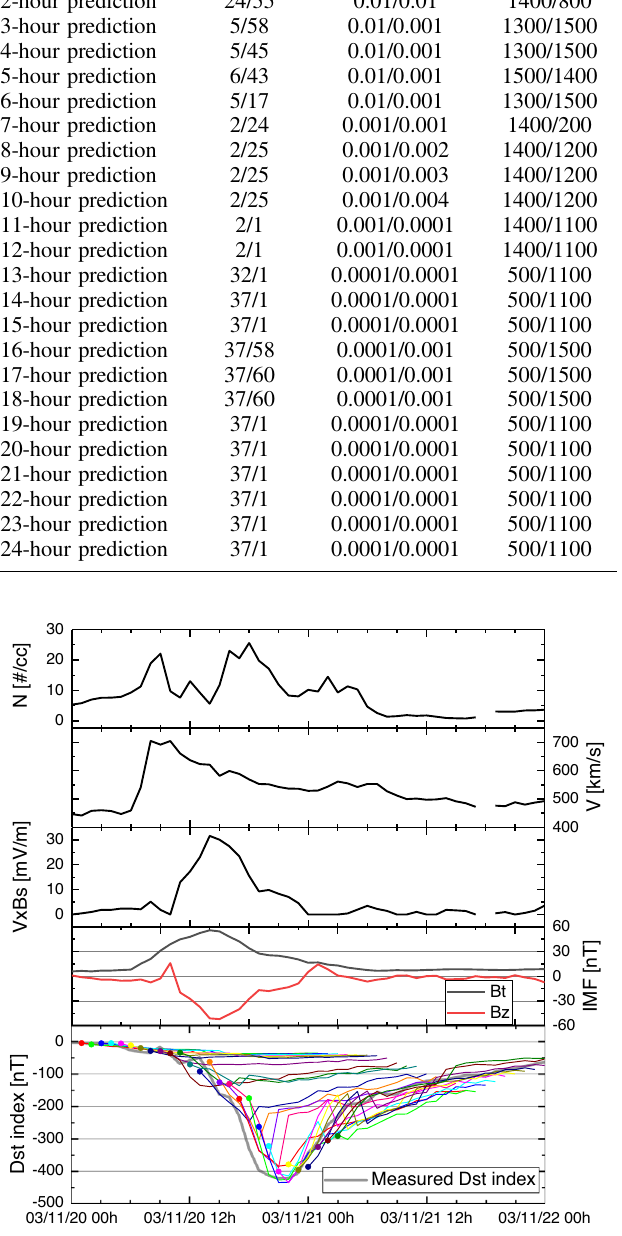
Fig. 5. Example of predicting the geomagnetic storm that occurred by CME on 20 November 2003. From top: (a) the solar wind density, (b) IMF total fi eld, (c) IMF Bz , (d) solar wind speed, V (cid:4) Bs , and (e) Dst index measured and predicted. In the bottom panel, the gray line shows the measured Dst index, the color dots indicate the value predicted 1 h at each hour, and the colored lines show predicted Dst values for 24 h with a one-hour interval.